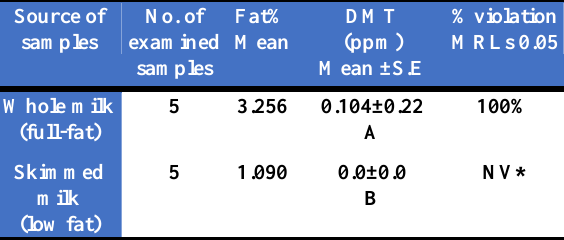
Table, 1: Comparison of the mean levels of Deltamethrin residues (ppm) between the cow's raw whole and skimmed milk samples collected from the Abu-Ghraib dairy plant.